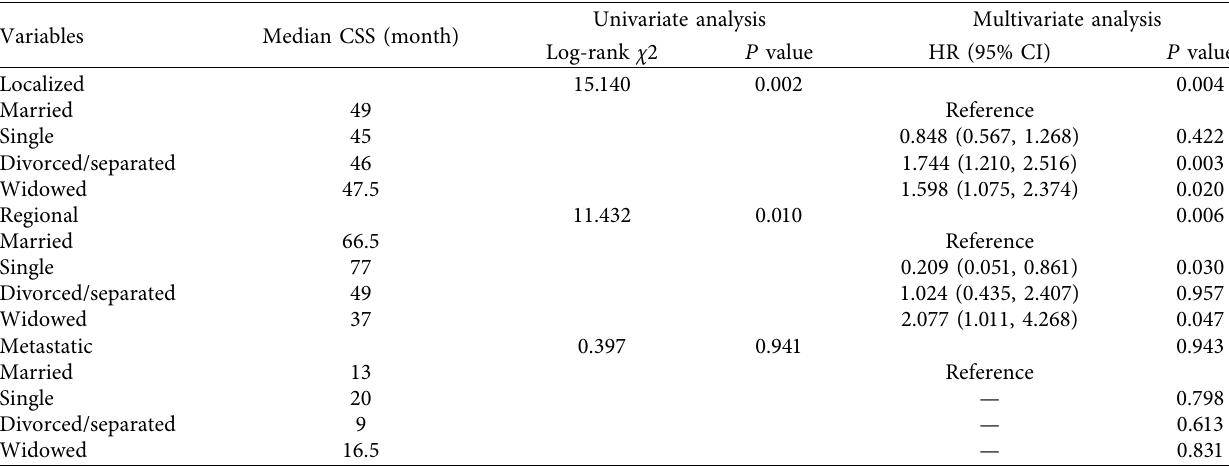
Figure 4: Kaplan–Meier comparison of OS and CSS among patients stratified by SEER stage. (a, b) Patients in the localized stage; (c, d) patients in the regional stage; (e, f) patients in the distant stage. Table 6: Univariate and multivariate analysis for evaluating the influence of marital status on OS according to SEER stage.